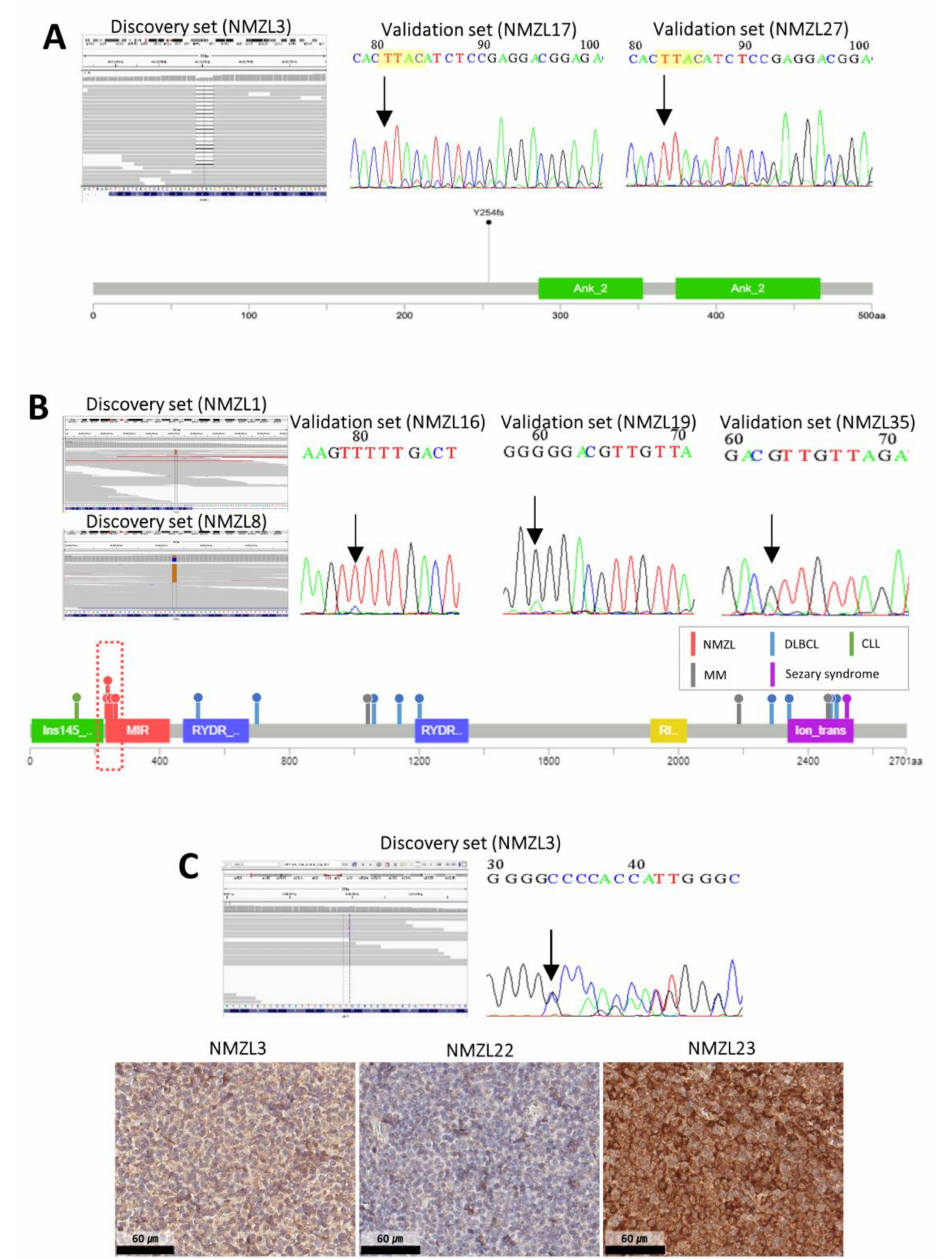
Figure 2. Validation of novel mutations found in the current study. ( A ) A 4-bp deletion frameshift mutation of NFKBIE (Y254fs) was found in NMZL3 by whole-exome sequencing (WES) (left), and direct sequencing identified another two patients in the validation set (NMZL17 and NMZL27) with the identical mutation (right). In total, three out of 38 (7.9%) patients with NMZL harbored this mutation (bottom). ( B ) WES revealed two patients in the discovery set with ITPR2 mutations (left). Direct sequencing was performed to identify alterations in the other NMZL patients (right). Of the NMZLs, 13.9% (5 / 36) had mutations in ITPR2 , all of which were predicted to be damaging and to a ff ect the MIR domain of ITPR2 (red box), whereas all ITPR2 mutations in other types of lymphomas a ff ected di ff erent sites (bottom). ( C ) NMZL3 patient harbored a frameshift mutation in CD70 (left), which was confirmed by direct sequencing (right). Immunohistochemistry (IHC) images with loss or attenuation of CD70 expression (NMZL3 and NMZL22) and intact CD70 expression (NMZL23) (bottom) are shown (abbreviations: multiple myeloma